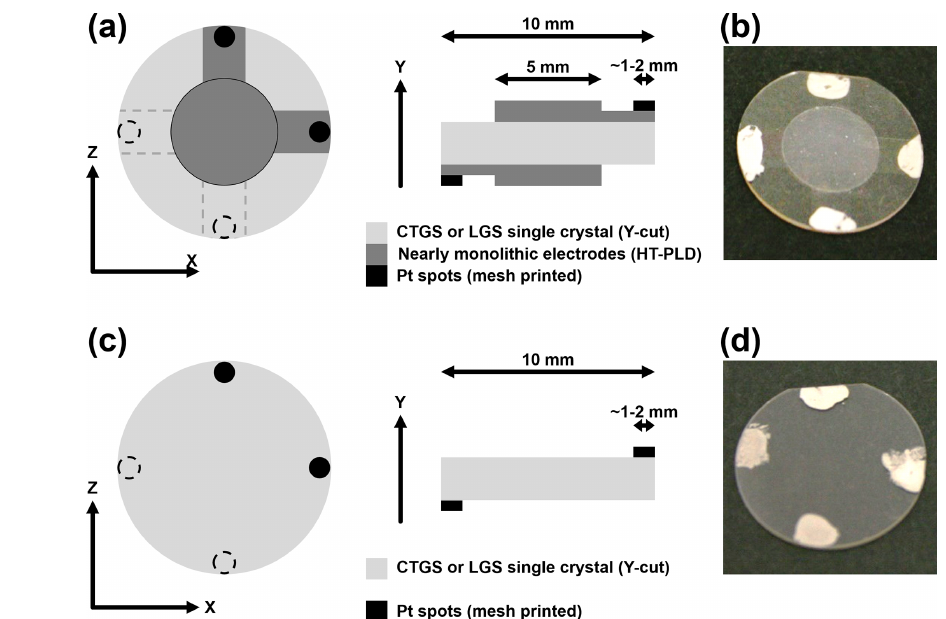
Figure 1. Scheme (a) and photograph (b) of the nearly monolithic piezoelectric resonators coated with oxide electrodes; scheme (c) and photograph (d) of the resonator blanks coated with Pt spots used for comparative study of the influence of the oxide electrodes.